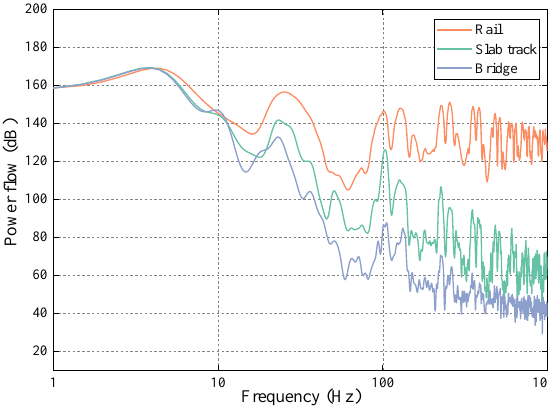
Figure 6. The power flows of the track–bridge system. Figure 4. The power flows of the track – bridge system.